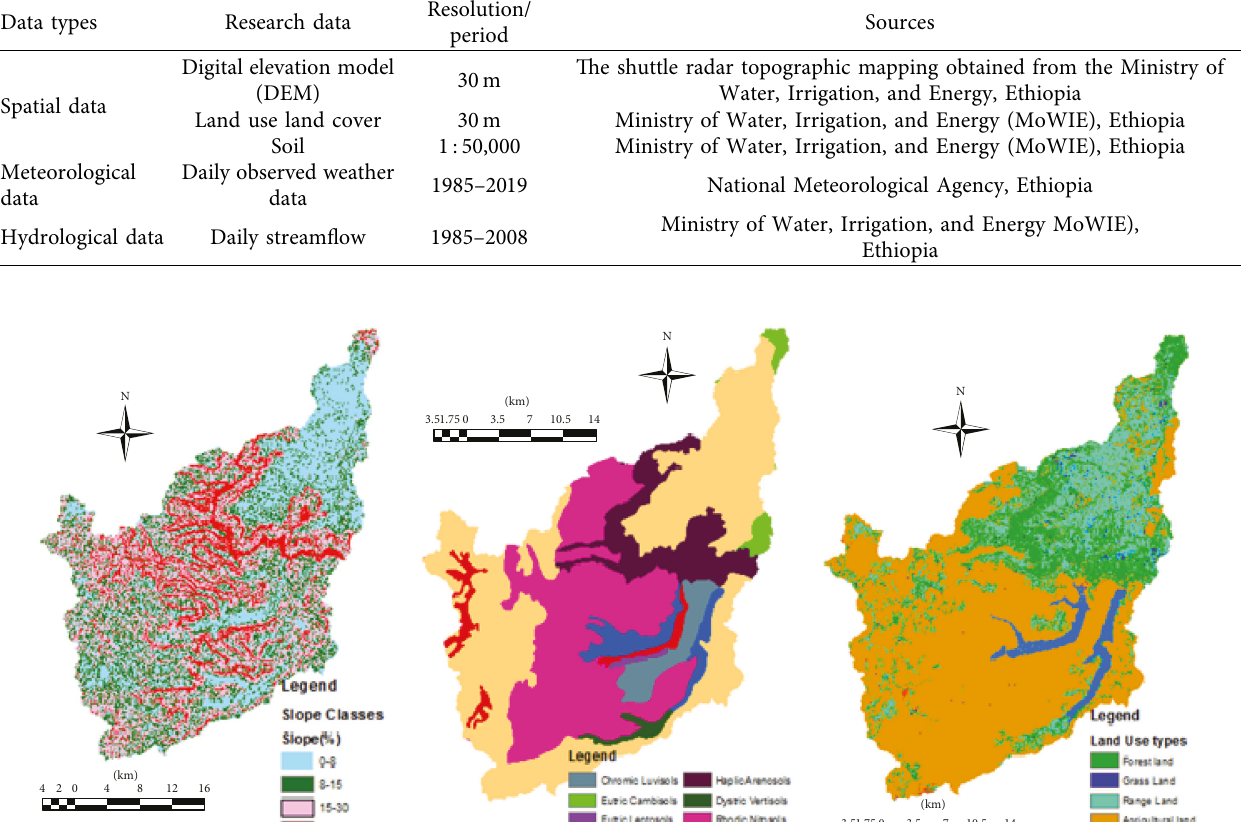
Table 1: Input data description used in the SWAT model.